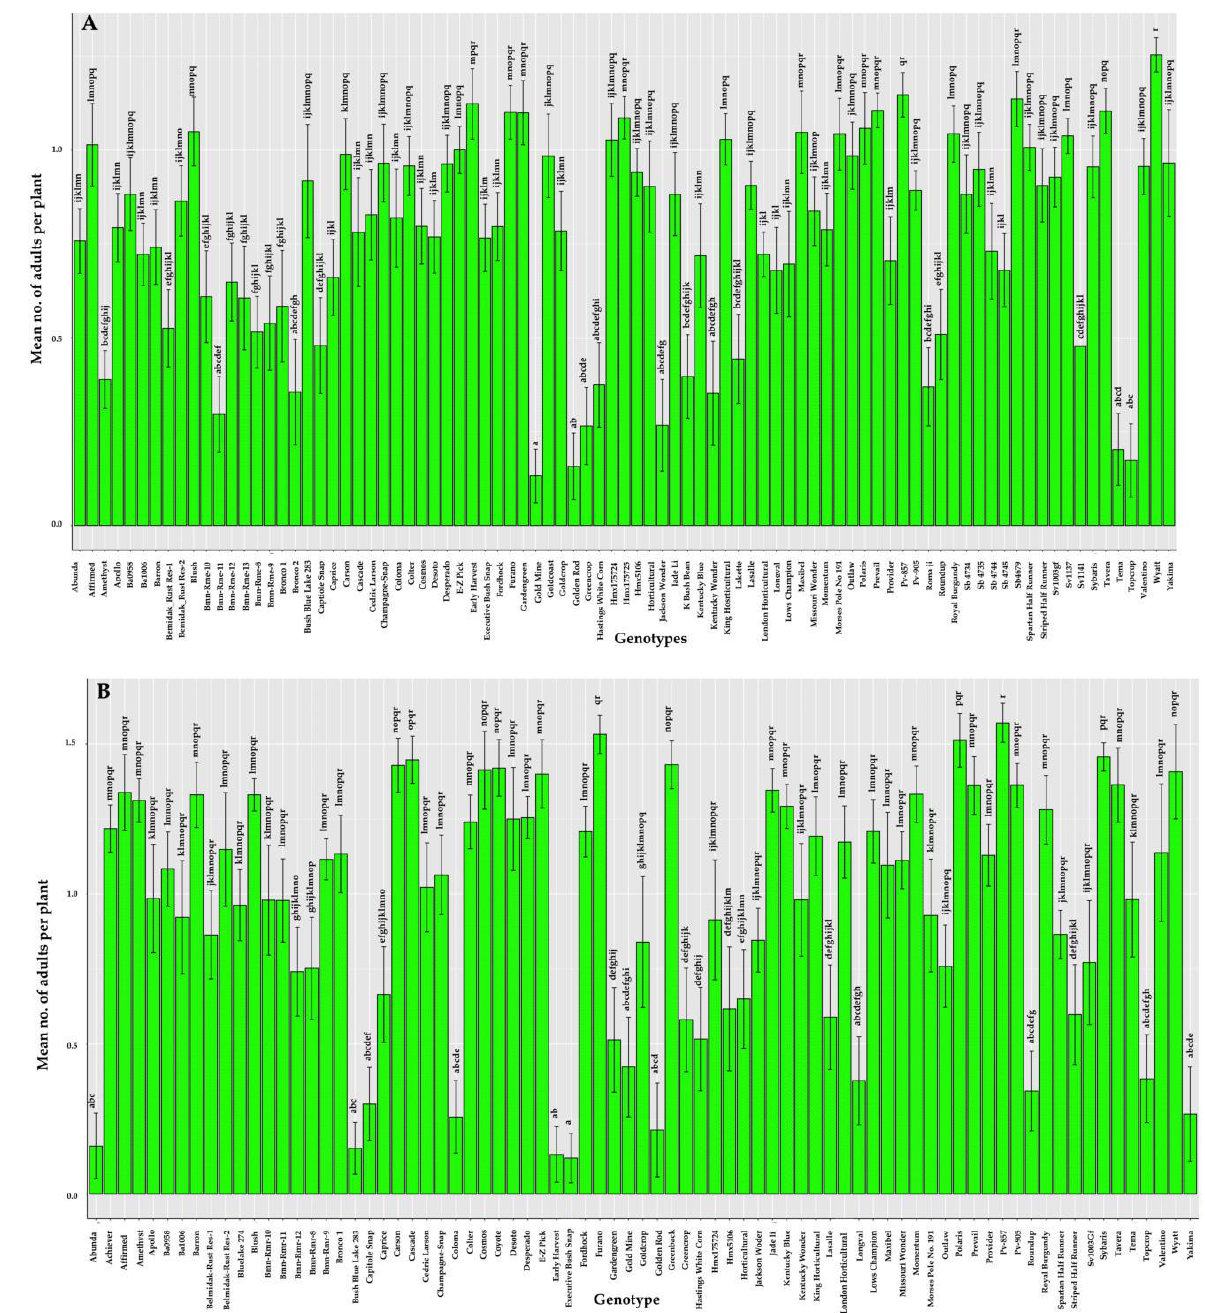
Figure 3. Mean number of whitefly adults counted on different snap bean genotypes in 2018 ( A ) and 2019 ( B ). Bars with standard errors represent the average number of whiteflies present on each plant of the genotype. Whiteflies adults were enumerated on the three top leaves of the plant. Y-axis is shown in a logarithmic scale. Bars with different letters are significantly different from one another ( p < 0.05).